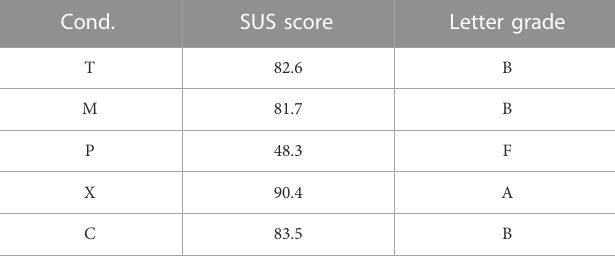
TABLE 5 The SUS score for all conditions and the corresponding letter grade. Cond.